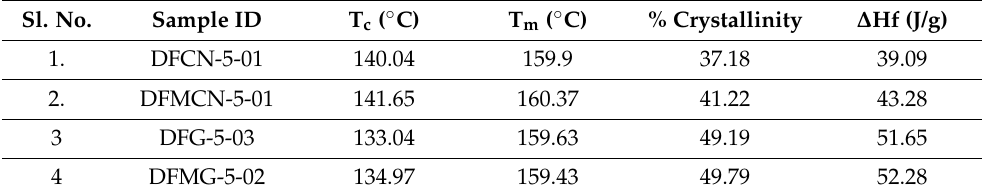
Table 2. Crystallinity of the nanocomposites obtained from DSC analysis. Sl.